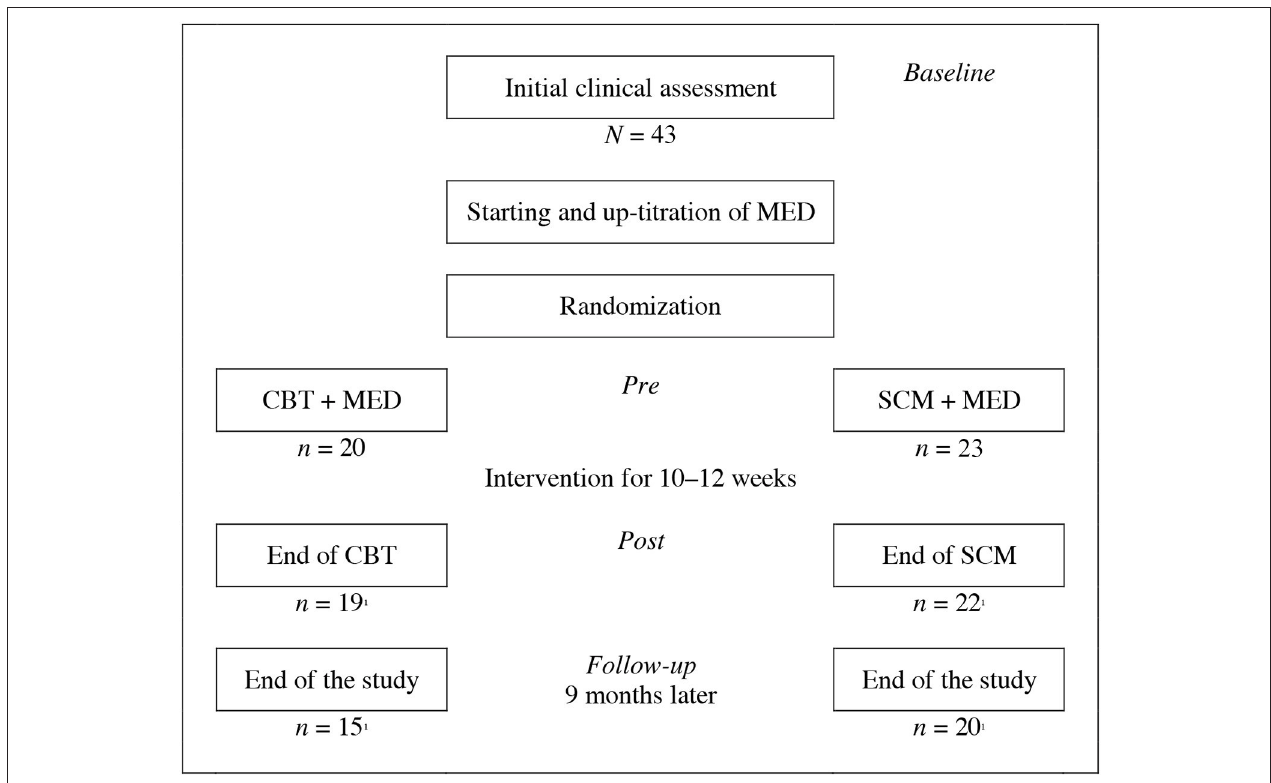
FIGURE 1 | Study design and procedure (baseline, pre, post, and follow-up evaluation). MED, Medication; CBT, Cognitive-behavioral therapy; SCM, Standard clinical management; 1 Patient(s) refused further participation.